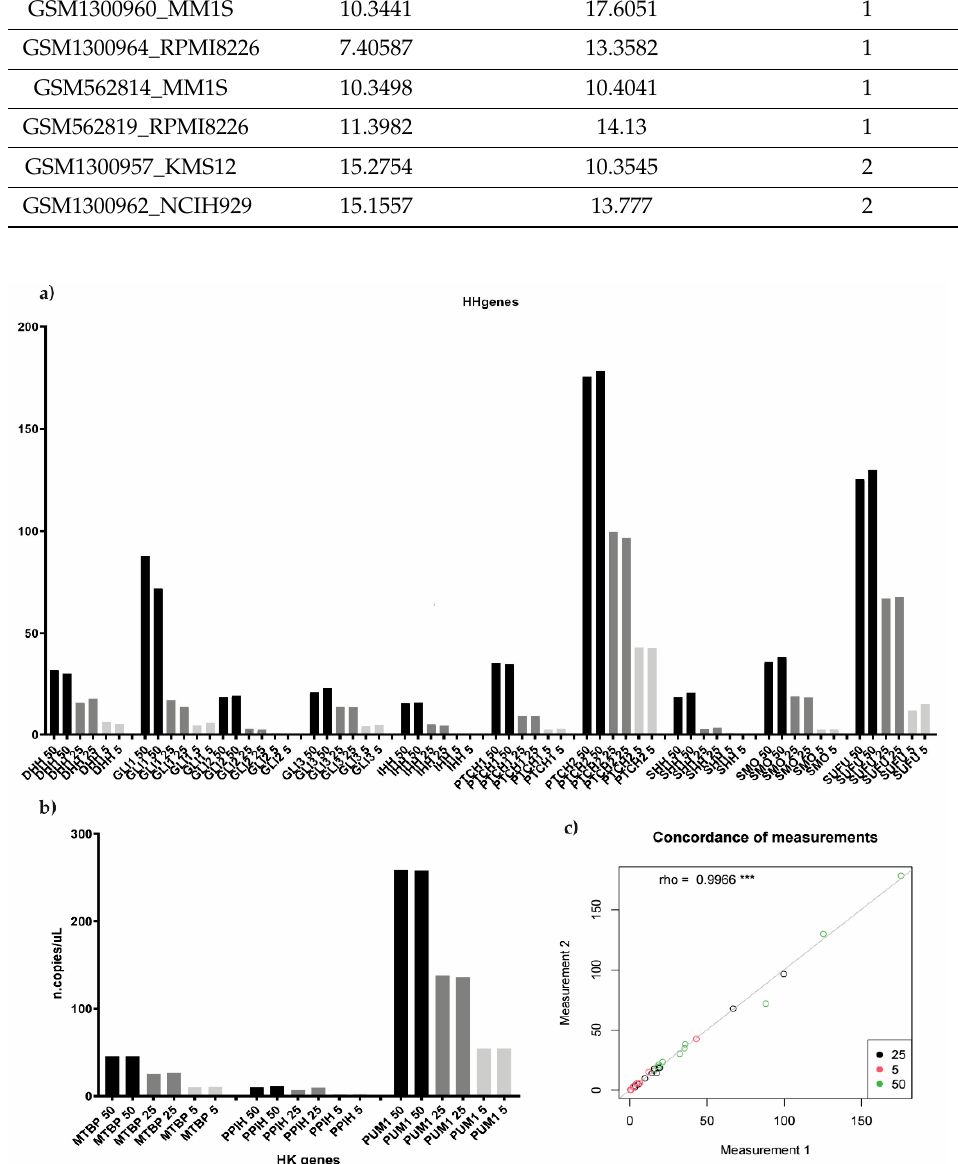
Table 2. Testing the 10 HH genes signature in MM cell lines. The signature was able to classify each cell line as belonging either to Cluster 1 (MM1S and RPMI-8226) or to Cluster 2 (KMS12.BM and NCI-H929), according to their distance in terms of gene expression from CLU1 or CLU2.